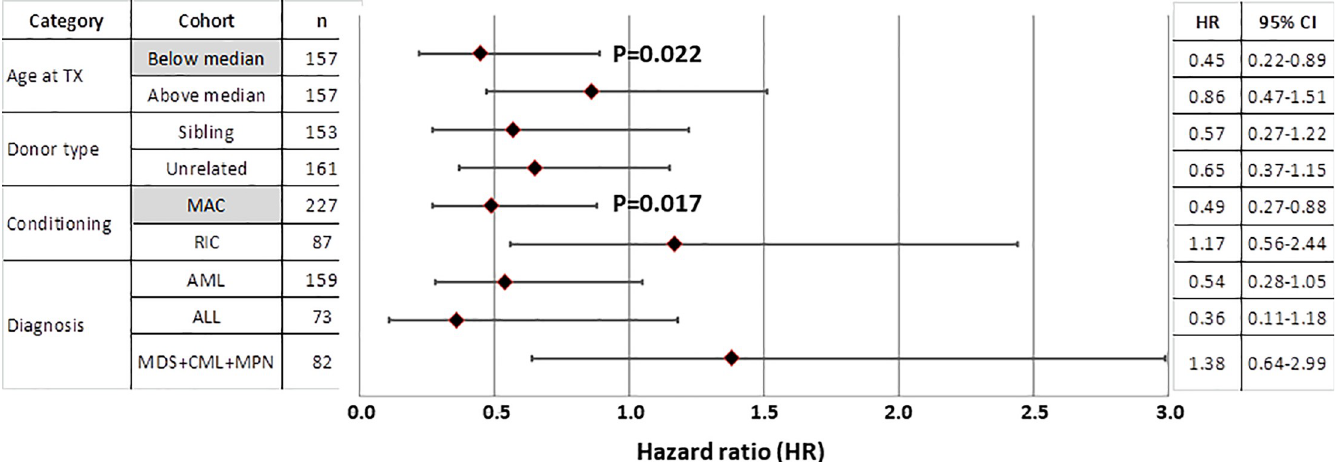
Fig 2. Effect of rC2+d2DS1 combination on overall survival (OS) as measured by multivariate Cox regression analyses in various subgroups. Multivariate Cox proportional hazard models were used calculating hazard ratio (HR) values along with 95% confidence intervals (95% CI) and p values (bold face character if > 0.05) after selecting the indicated subgroup using age, sex, donor type, conditioning and diagnosis as covariates in all subgroups. Cohort sizes (n) are indicated on the left, while HR values with 95% CI on the right. The presence of rC2+d2DS1 significantly improved OS in only 2 subgroups (grey filled cells), for which p values are indicated. Other p values were not significant ( > 0.05) and are not shown. Abbreviations : AML = acute myeloid leukemia, ALL = acute lymphoblastic leukemia, CI = confidence interval, CML = chronic myeloid leukemia, d2DS1 = donor KIR2DS1 gene, GvHD = graft-versus-host disease, HR = hazard ratio, MAC = myeloablative conditioning, MDS = myelodysplastic syndrome, MPN = myeloproliferative neoplasm, rC2 = recipient HLA-C2 group allele, RIC = reduced intensity conditioning, TX = transplantation.